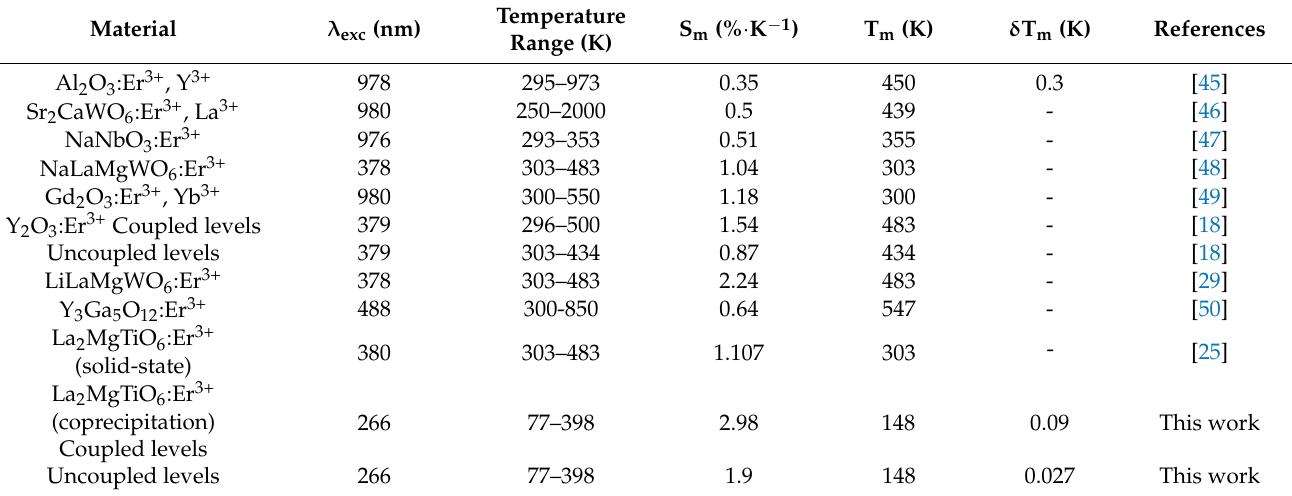
Table 1. The maximum relative sensitivity S m (% · K − 1 ) of some materials doped with Er 3+ corresponding to thermally coupled level and uncoupled levels at temperature T m (K) with temperature uncertainty δ T m (K).